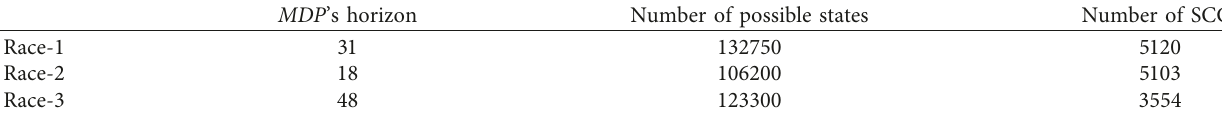
Figure 2: Racetrack’s example. Table 1: Characteristics of the three racetracks.